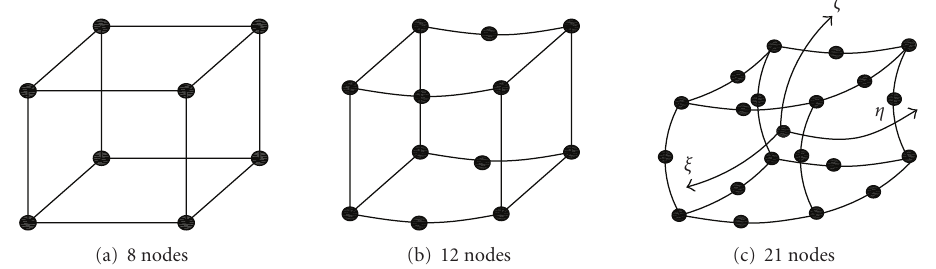
Figure 1: Variable node 3D solid